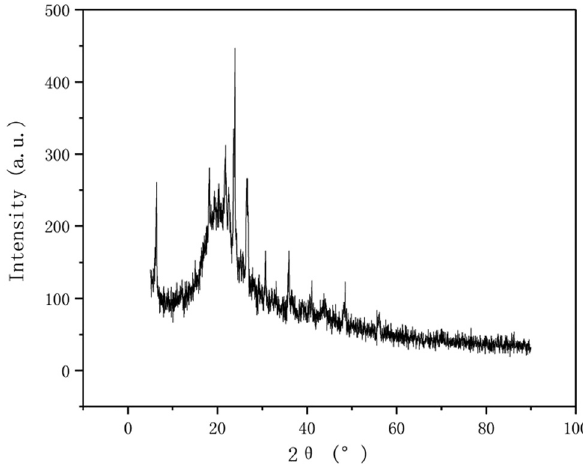
Figure 4: XRD patterns of WPU/PANI. Figure 5: Fluorescence spectra of